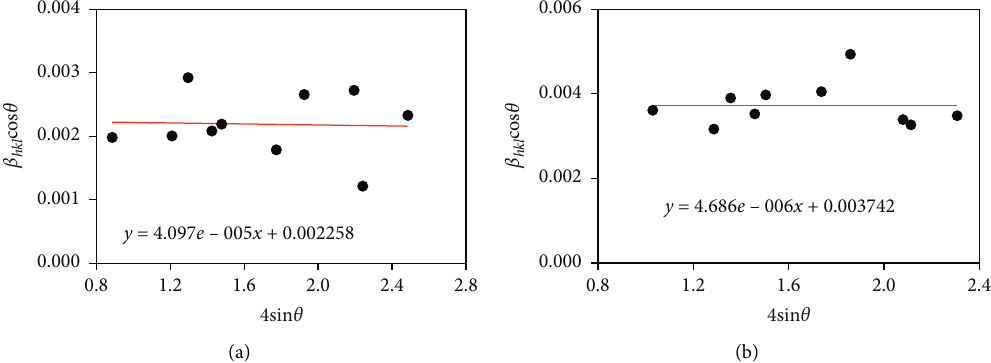
Figure 2: UDM plot for Al 2 O 3 /10wt. % SiC sample: (a) electrical resistance heating sintering and (b) microwave sintering.